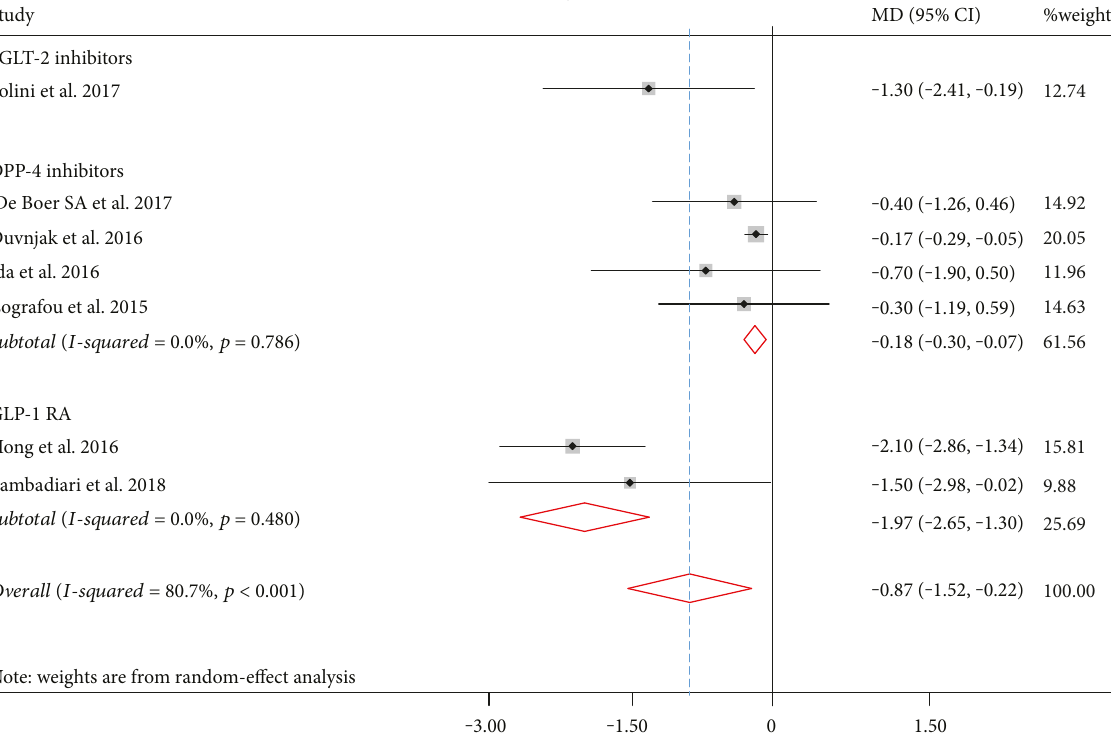
Figure 3: E ff ects of newer antidiabetic drugs on arterial sti ff ness. Squares indicate the mean di ff erence (MD) and the respective 95% con fi dence intervals in pulse wave velocity (PWV) before/after treatment from eligible studies. The size of the squares corresponds to the weight of each study. The diamonds and their width represent the pooled weighted MD and the 95% CI, respectively. DPP-4: dipeptidyl peptidase-4; GLP-1 RAs: glucagon-like peptide-1 receptor agonists; SGLT-2: sodium-glucose cotransporter-2. Funnel plot with pseudo 95% confidence limits